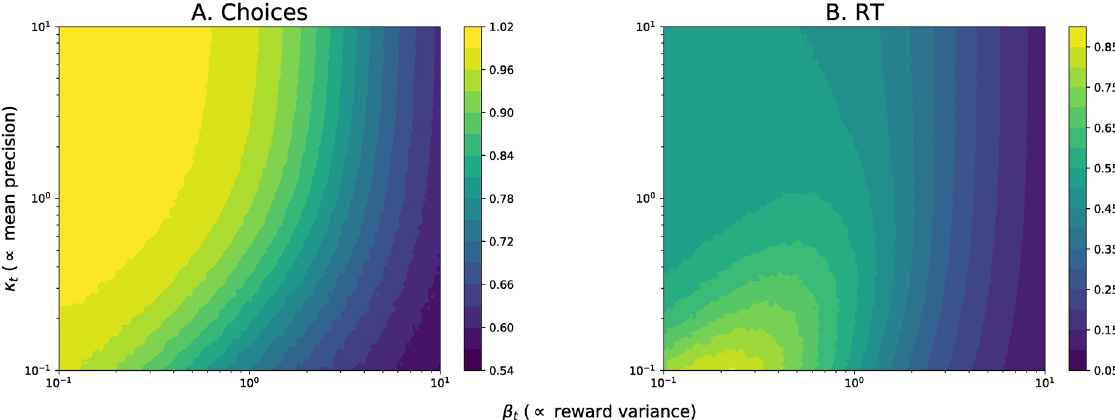
Fig 3. Simulated policies for the AC-HAFVF as a function of reward variance β j and number of effective observations κ j , for a fixed value of posterior mean rewards ( μ 1 = − μ 2 = 1), shape parameter α 1 = α 2 = 3 threshold z = 2, start point z 0 = z /2 and τ = 0. A . Choices were more random for more noisy reward distributions (i.e. high values of β ) and for mean estimates with a higher variance (i.e. with a lower j number of observations κ j ). B . Decisions were faster when the difference of the means was clearer (high κ j ) and when the reward distributions was noisy (high β ). Subjects were slower to decide what to do for noisy mean values but precise rewards, reflecting the high cognitive cost of the decision process in these